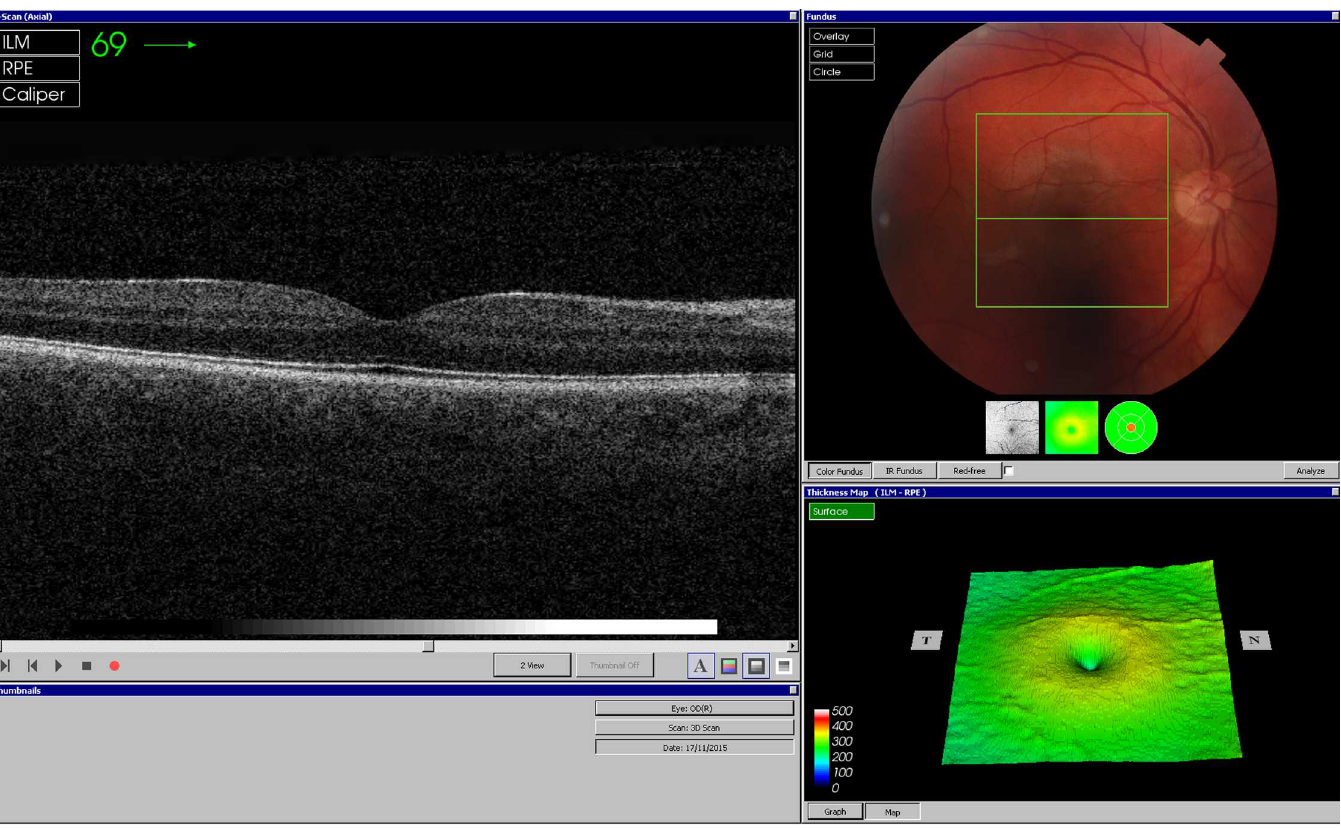
Fig 1. Optical coherence tomography (OCT) image sets. OCT image sets were obtainedusing a raster scan protocol on a spectral domain OCT system (3D OCT-1000 Mark II, Topcon,